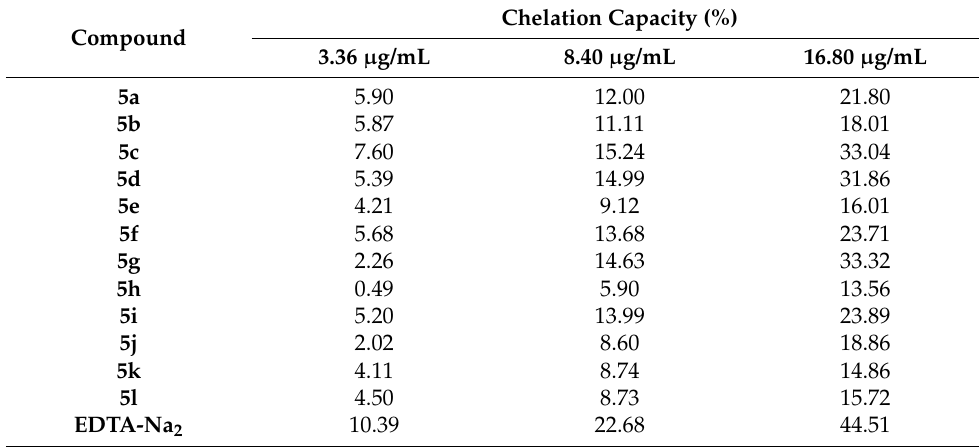
Table 6. Results of the cupric ion chelating capacity